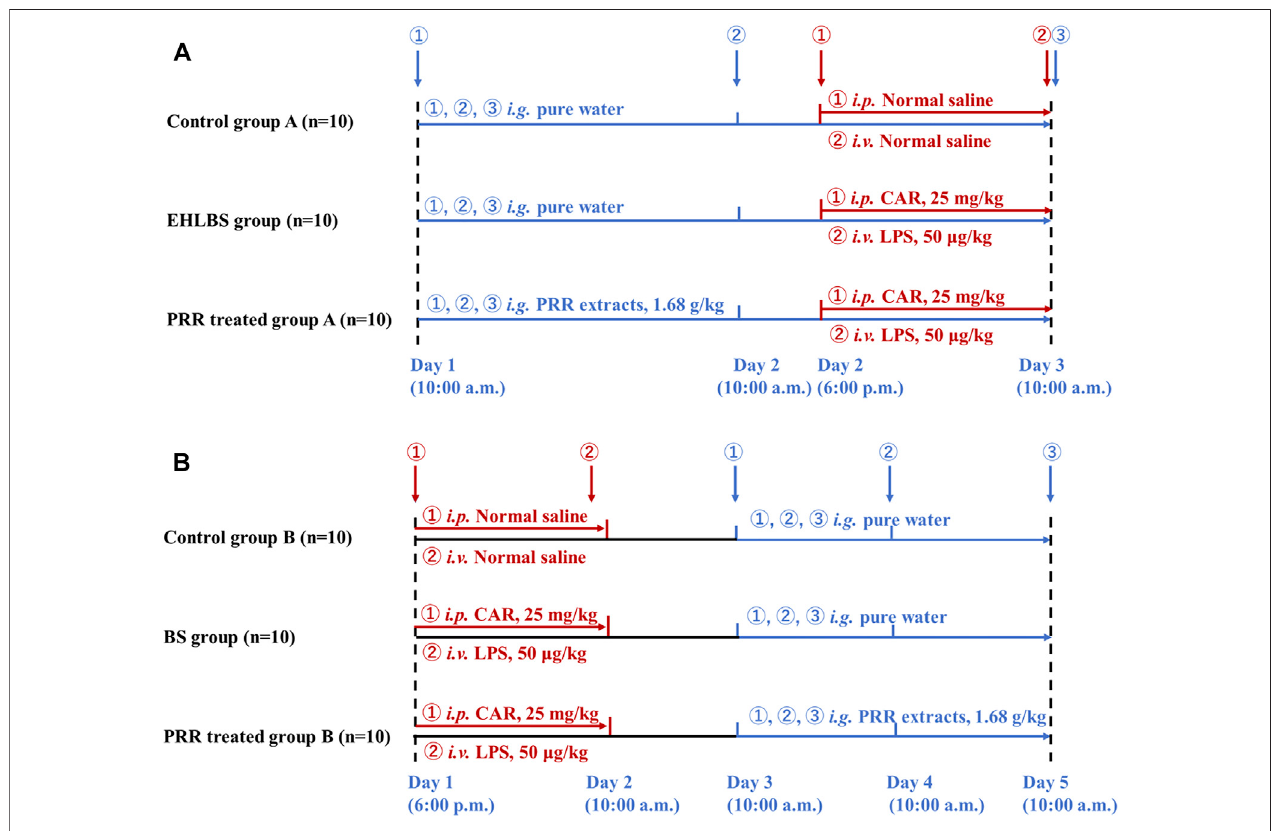
FIGURE 1 | The dosage regimens for EHLBS stage (A) and BS stage (B)